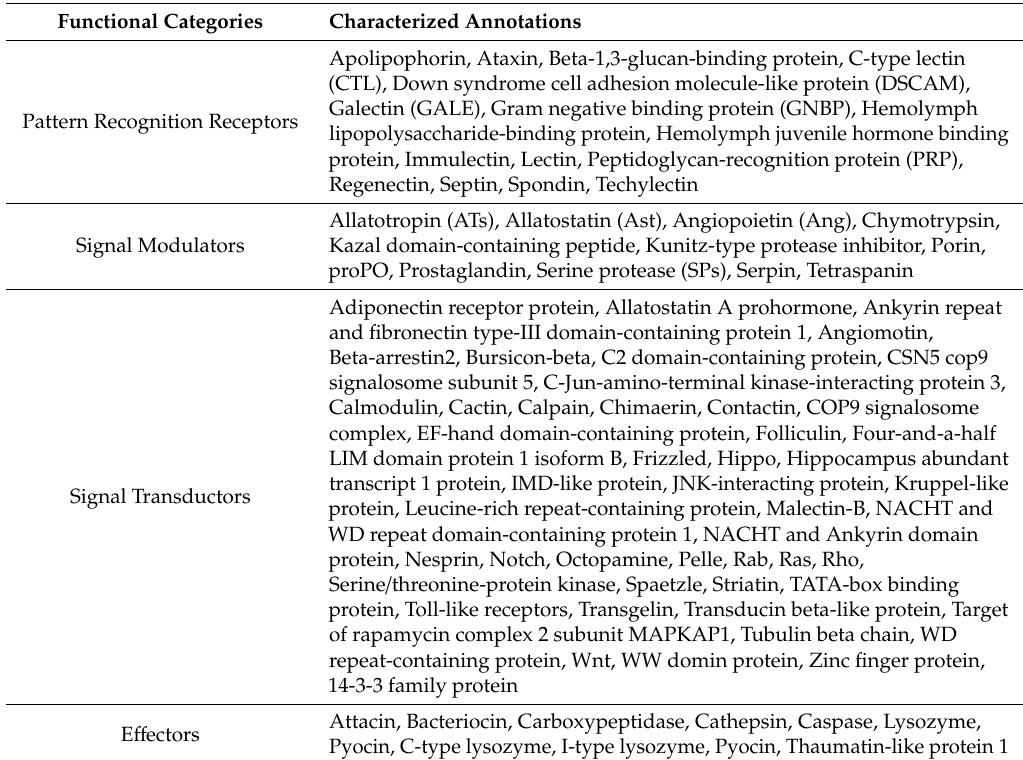
Table 3. Immune-related transcriptome of two-spotted field